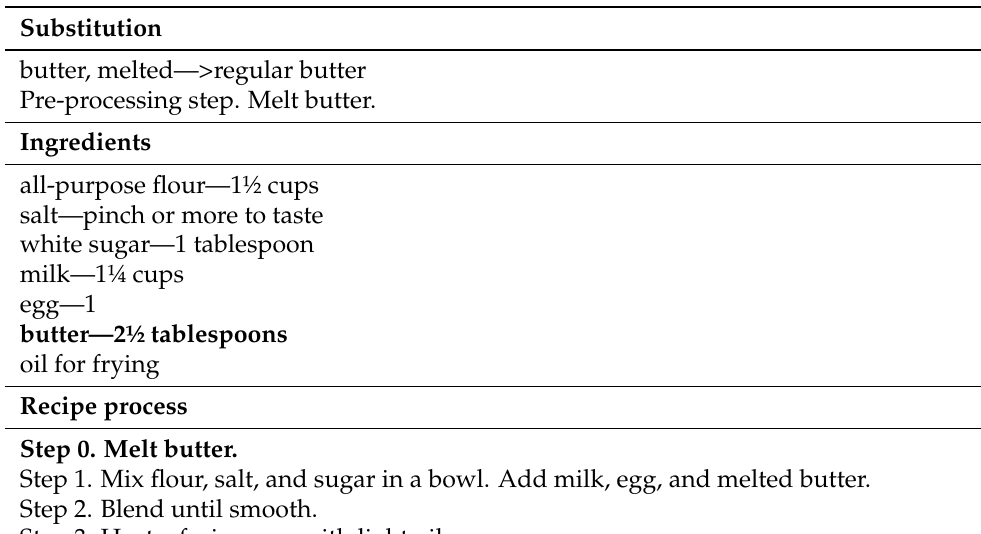
Table 4. Example substitution for a recipe for pancakes and the changed recipe. (Source recipe in Table